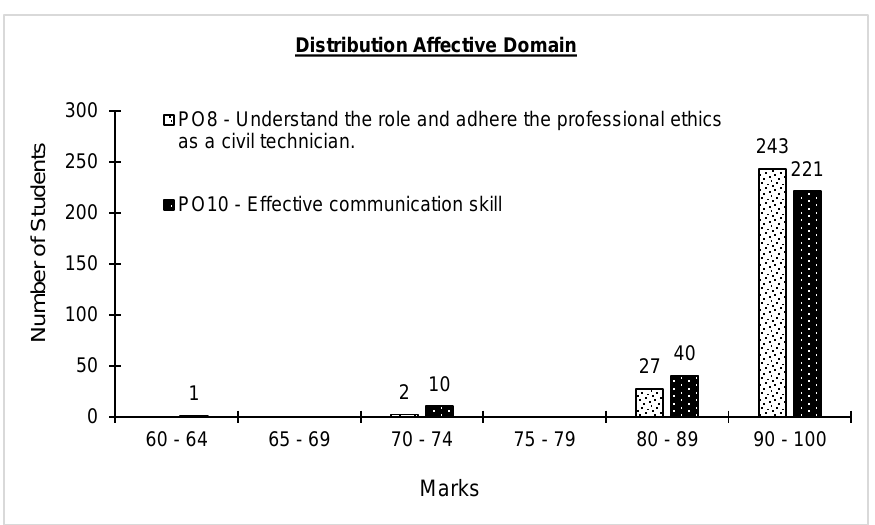
Fig. 1. Distribution of students’ performance according to the psychomotor domain